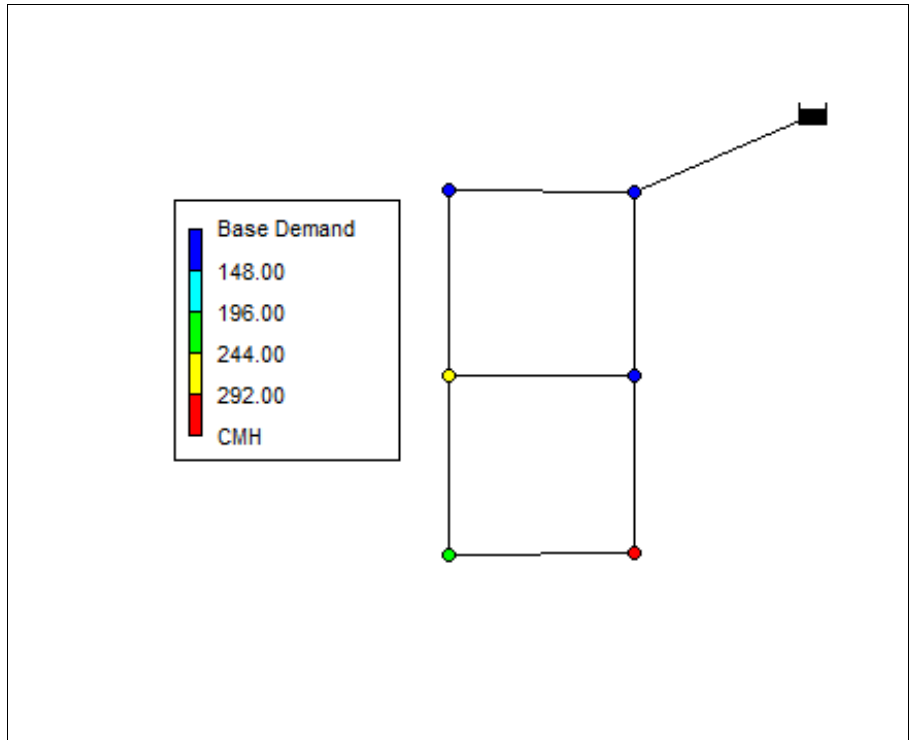
Figure 2. Topology and nodal demand for the 2-loop